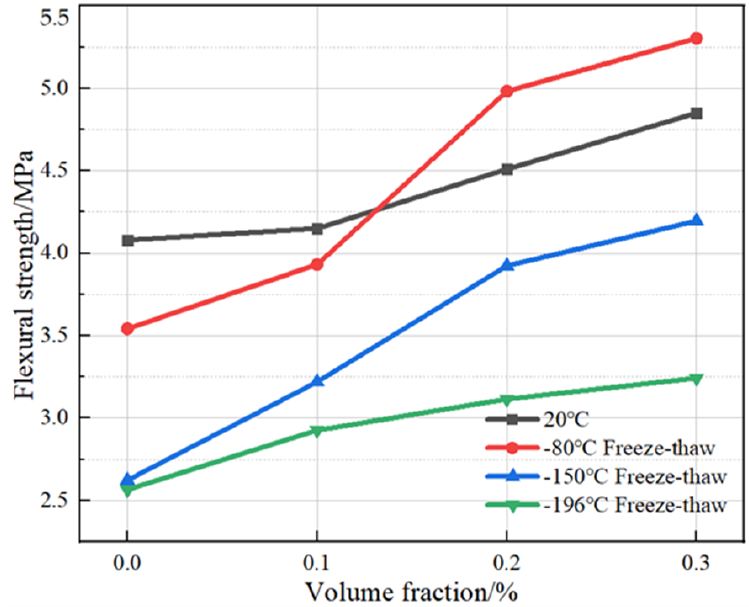
Figure 20. Effect of fiber volume on the flexural strength of BFRC.